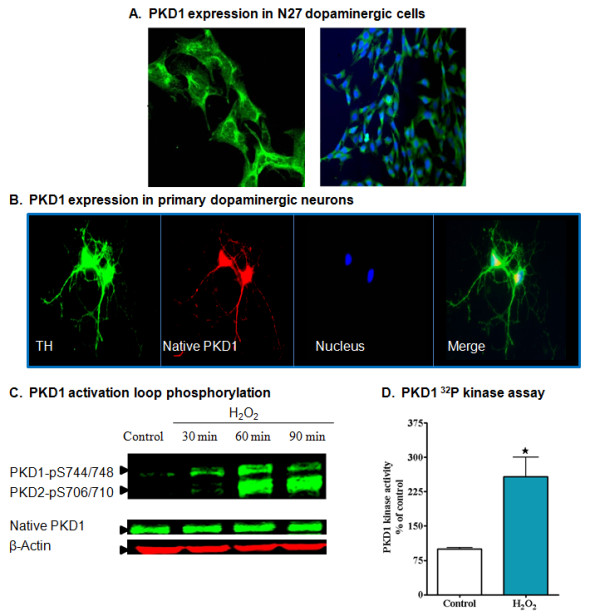
PKD1 is highly expressed in dopaminergic neurons and activated during initial stages of H2O2 -induced oxidative stress. Immunofluorescence analysis of N27 dopaminergic cells stained for native PKD1 using fluorescence and confocal microscopy. Nuclei were stained with Hoechst dye (A). Primary dopaminergic neurons staining for tyrosine hydroxylase (TH) obtained from the mouse substantia nigral region show co-localization of native PKD1 with TH. TH - Green, PKD1 native - Red, Nucleus - Blue, Yellow -Merge. Nuclei were stained with Hoechst dye (B). N27 dopaminergic neuronal cells were treated with or without H2O2 (100 μM) for 30, 60 or 90 min and probed for PKD1 activation loop phosphorylation pS744/pS748 and native PKD1 expression (C). N27 cells were treated with or without H2O2 (100 μM) and PKD1 kinase activity was measured by [32P] kinase assay using syntide 2 substrate at 60 min (D). *, p < 0.05 denotes significant difference between untreated and H2O2 -treated groups.